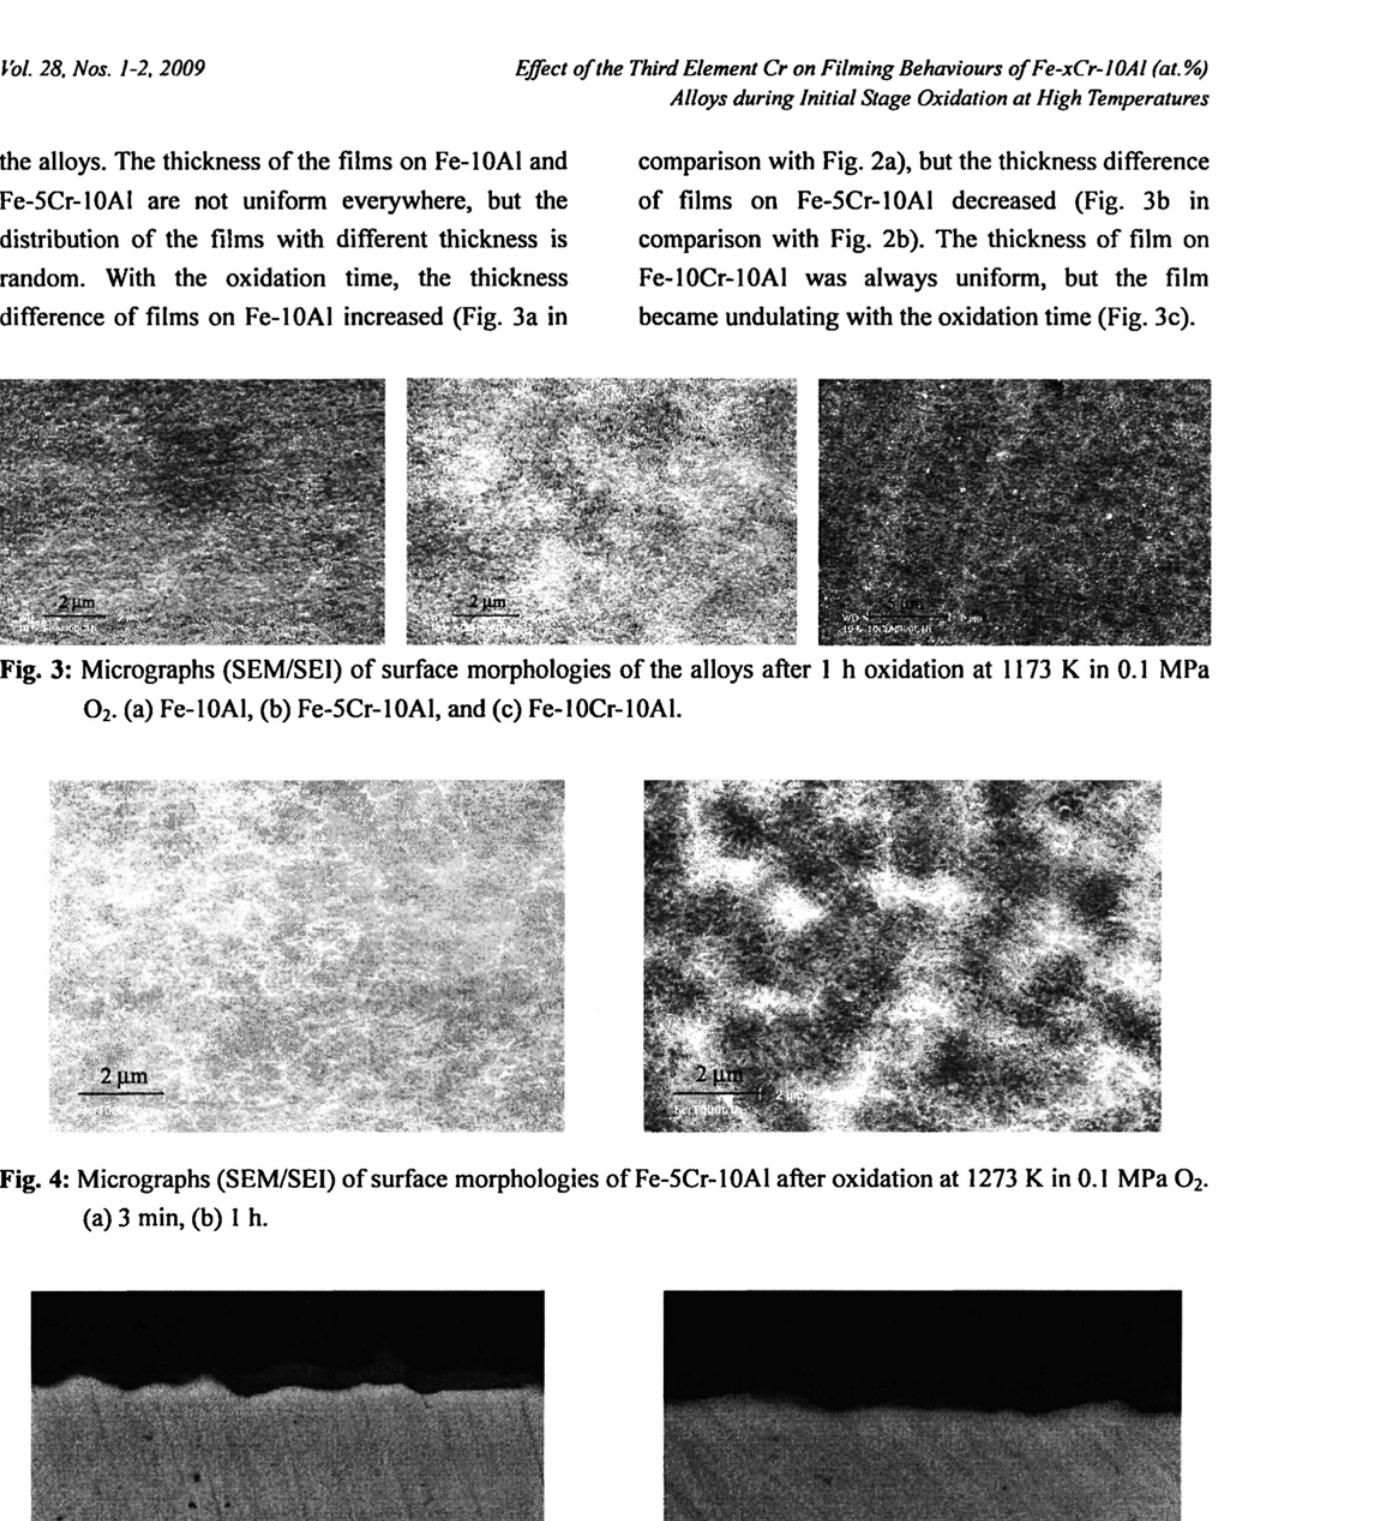
Fig. 5: Micrographs (SEM/BEI) of cross-section of the alloys after l h oxidation at 1273 K in 0.1 MPa O